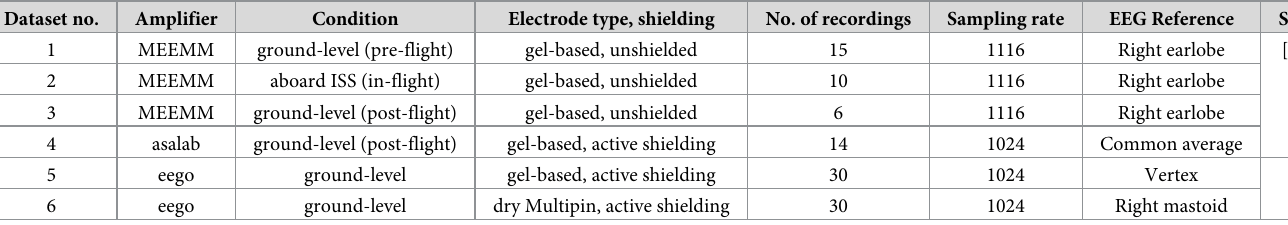
Table 1. EEG dataset